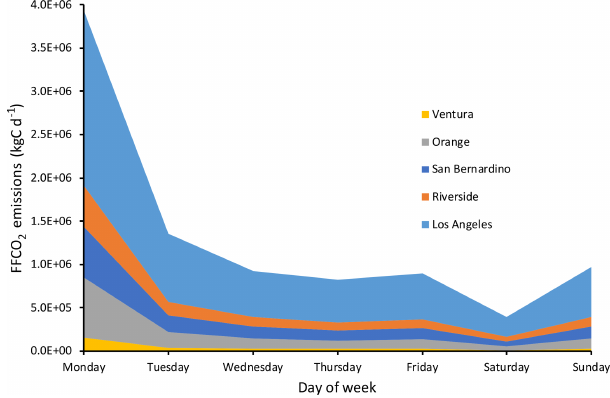
Figure 16. Average weekly on-road FFCO 2 emissions from the Hestia-LA v2.5 data product for five counties. Units: kgCd − 1